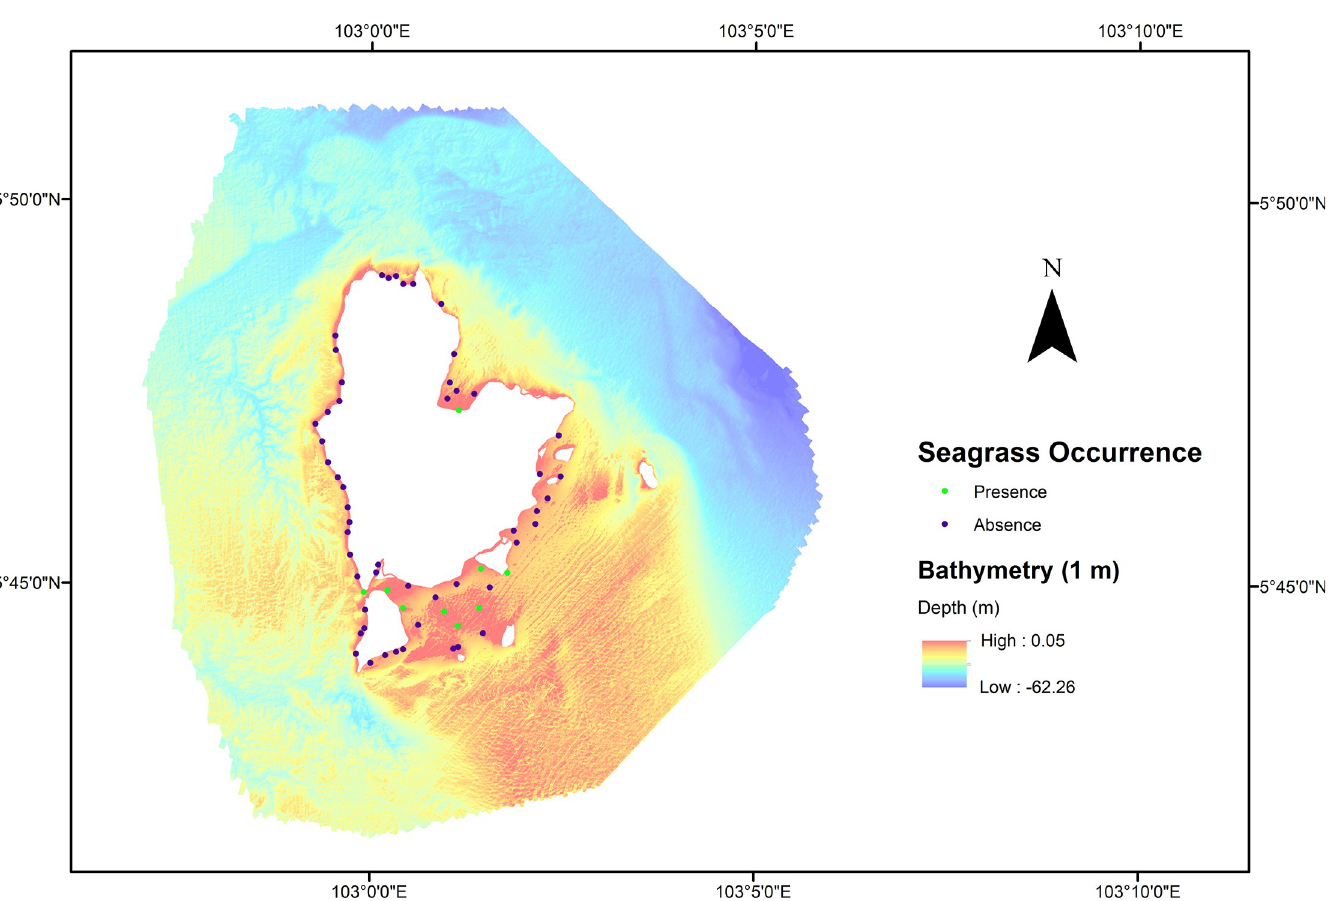
Fig 2. Bathymetry map of Redang archipelago. Bathymetry map of the study area. Red and blue dots represent the presence and absence of seagrass occurrence,